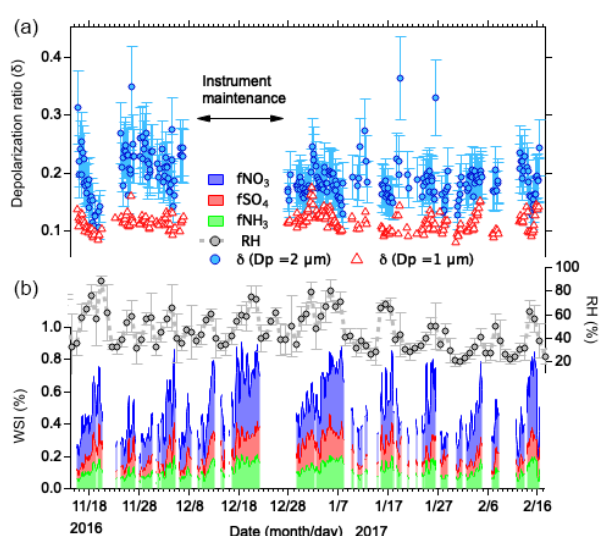
Figure 5. Temporal variabilities in δ values for particles at sizes of 1 and 2µm (a) and mass fraction of water-soluble inorganic matter (WSI, blue: nitrate; red: sulphate; green: ammonium) in PM 2 . 5 and ambient RH (b)